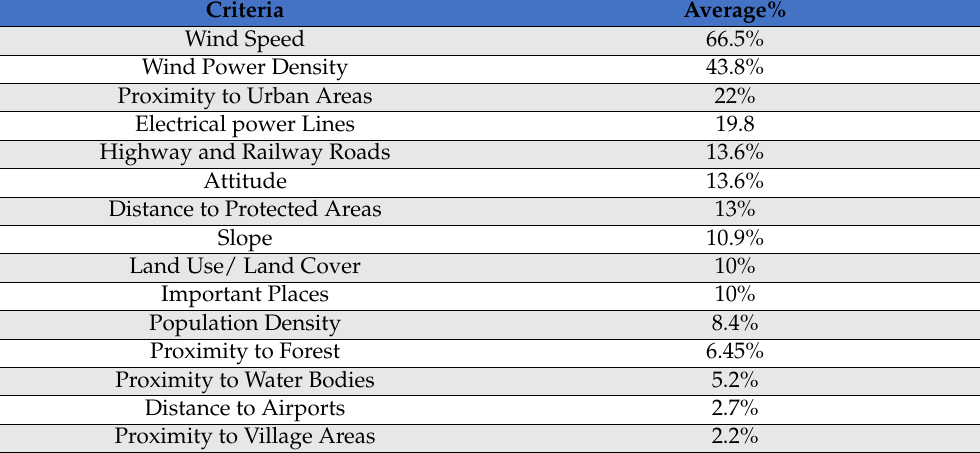
Table A1. Top Criteria that Were Weighed and Had a Very Strong Impact on the Study.